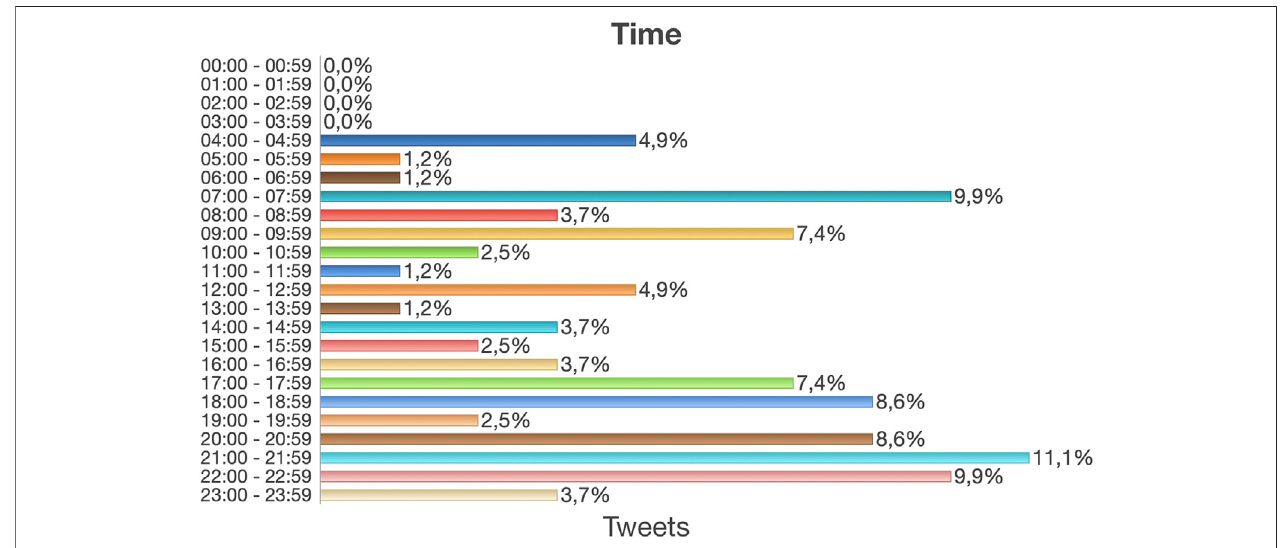
FIGURE 9 | Time of the day of the ABCA posts.